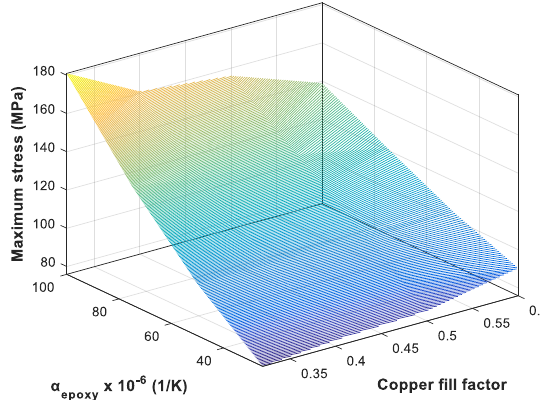
Figure 15. The maximum stress in the epoxy, plotted as a function of the copper fill factor and the coefficient of thermal expansion of the epoxy when the temperature distribution is non-uniform.